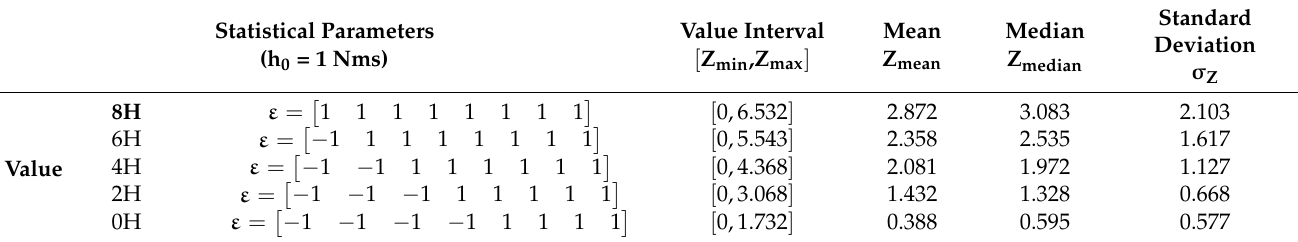
Figure 6. Singular momentum envelopes of 8−SGCMGs. Table 2. Statistic of singular momentum envelops of 8−SGCMGs.